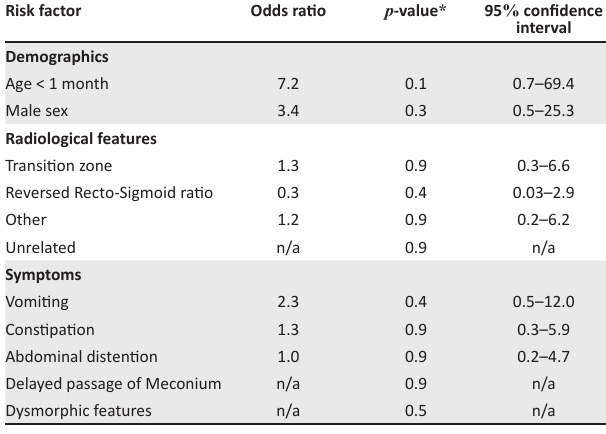
TABLE 4: Risk factors associated with true-positives. Risk